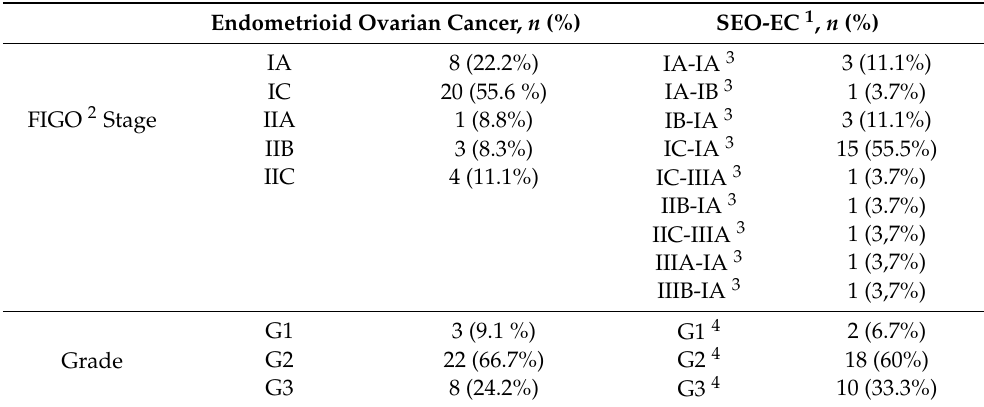
Table 1. Staging and grading in endometrioid ovarian cancer and synchronous endometrial-ovarian endometrioid cancer populations.